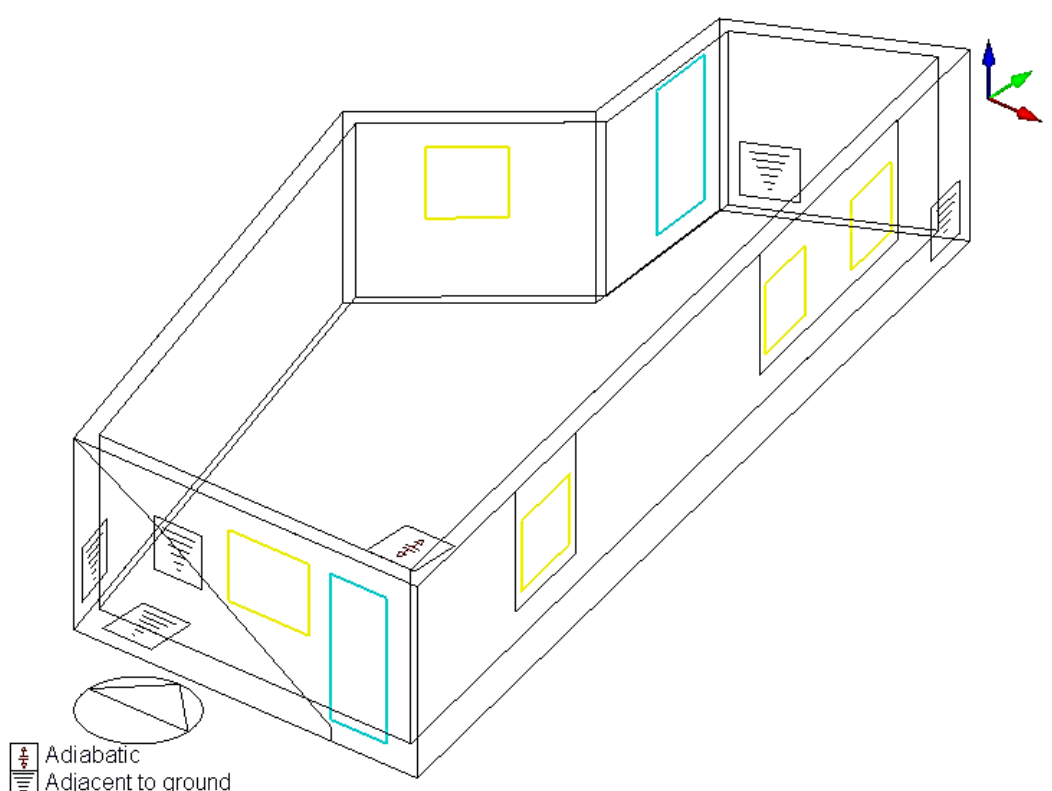
Figure 7. The basement zone’s adjacencies conditions.